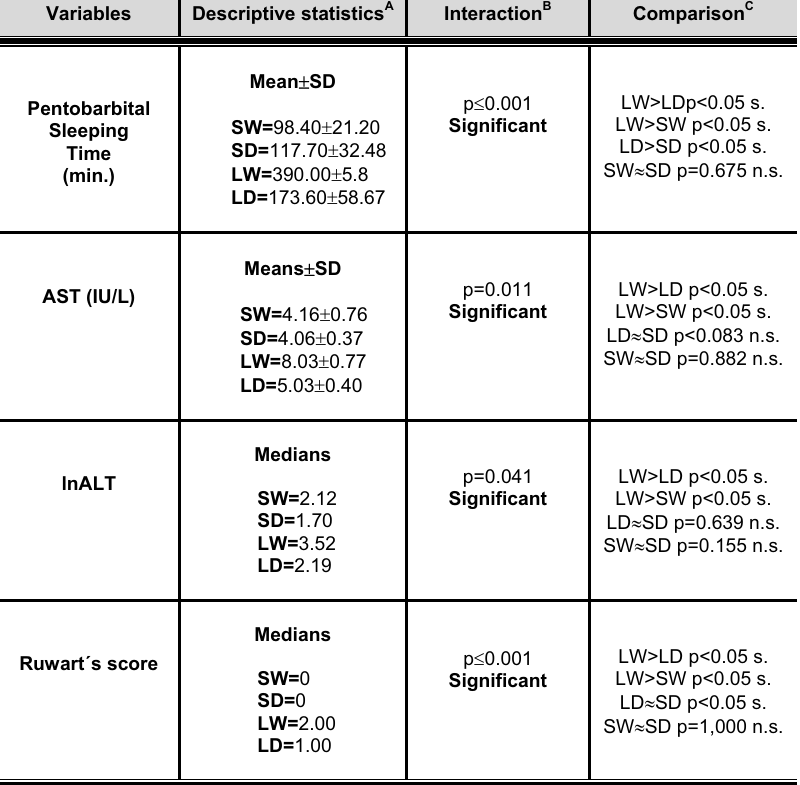
TABLE 1 – Pentobarbital sleeping time, aminotransferase serum activities (ALT and AST) and Ruwart´s score - descriptive analysis, interaction and comparisons between effects of cholestasis and of